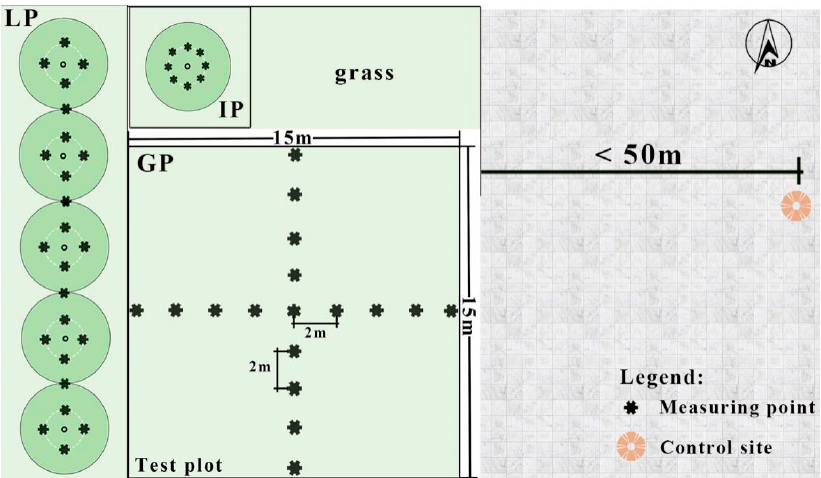
Figure 3. Schematic diagram of measuring points in three configuration modes. IP: individual planting;